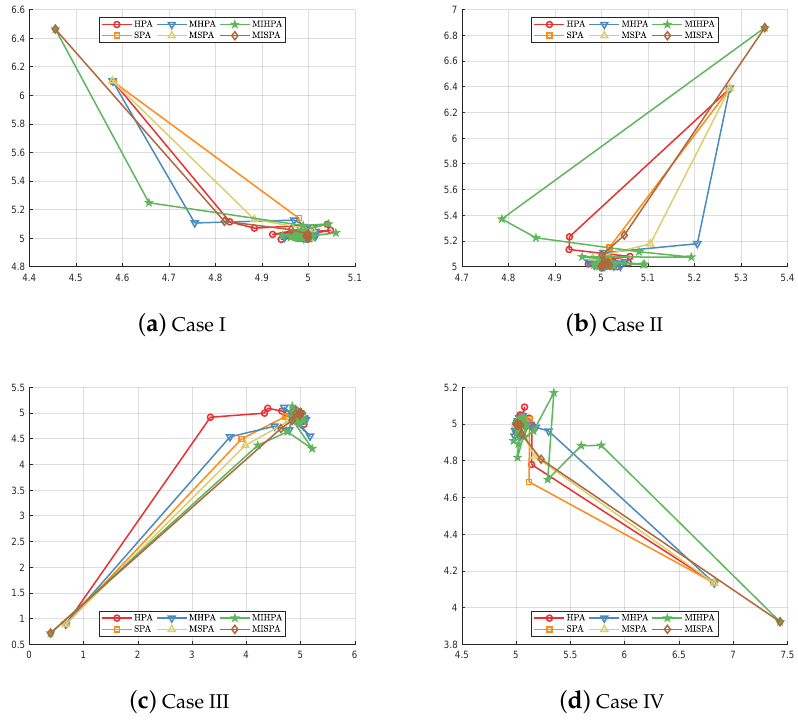
Figure 1. Convergence process at different initial values for Example 3.